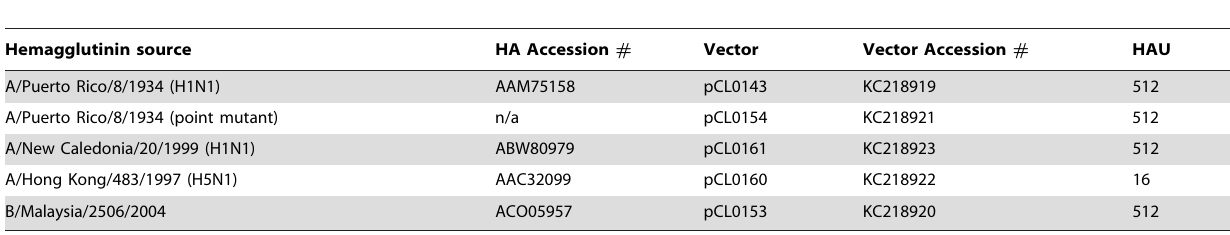
Table 1. Hemagglutinin sequences and corresponding vectors containing the codon-optimized nucleic acid sequences with their accession